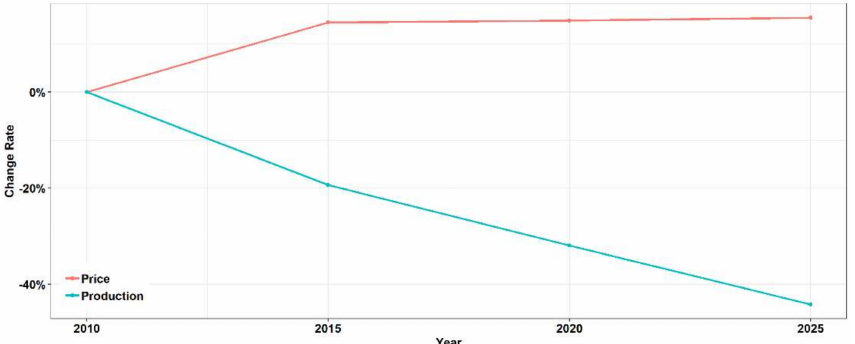
Figure 6. Particleboard price and production change under matching payment